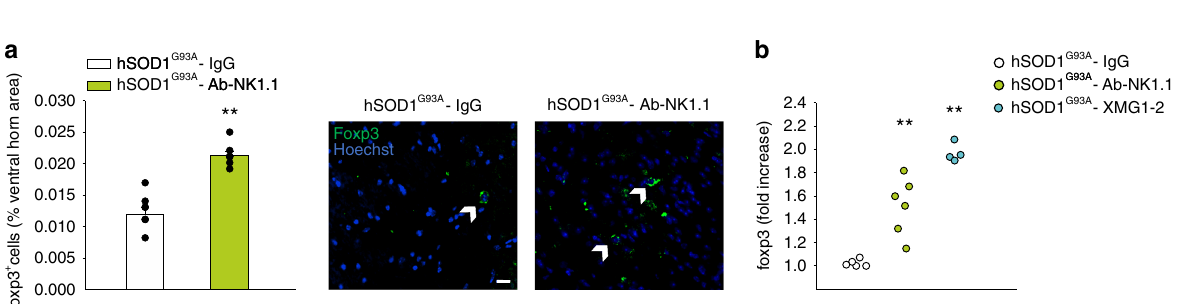
Fig. 6 NK cells mediate Treg recruitment in the spinal cord of hSOD1 G93A mice. a Analysis of Foxp3 + cells in the spinal cord of hSOD1 G93A mice (13 weeks) treated with vehicle or Ab-NK1.1, expressed as % of spinal cord area ± s.e.m. ( n = 5, ** P < 0.01 power 1 two-tailed Student ’ s t -test). Representative immuno fl uorescence on the right. Error bars show mean ± SEM. Scale bar: 20 μ m. b RT-PCR analysis of foxp3 expression in the lumbar spinal cord of hSOD1 G93A mice (13 weeks) treated with control IgG ( n = 5), Ab-NK1.1 ( n = 6) or XMG1.2 ( n = 5), (** P < 0.01 power 921 vs control, one-way ANOVA). Source data are provided as a Source Data fi